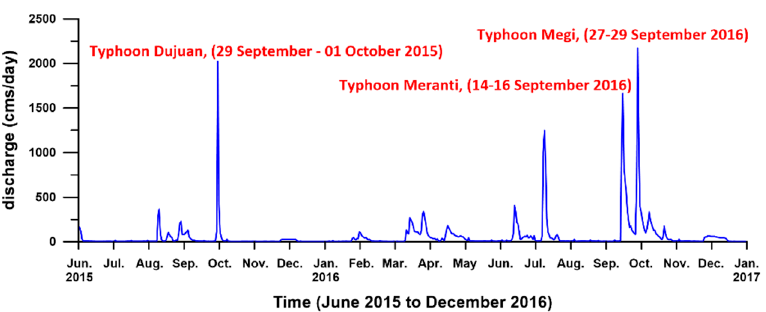
Figure 7. Bottom elevation of the Zhuoshui River.